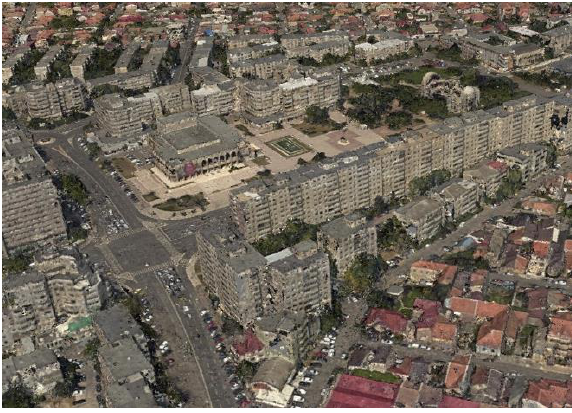
Figure 10. 3D model (point cloud) generated from the calibra- tion mission